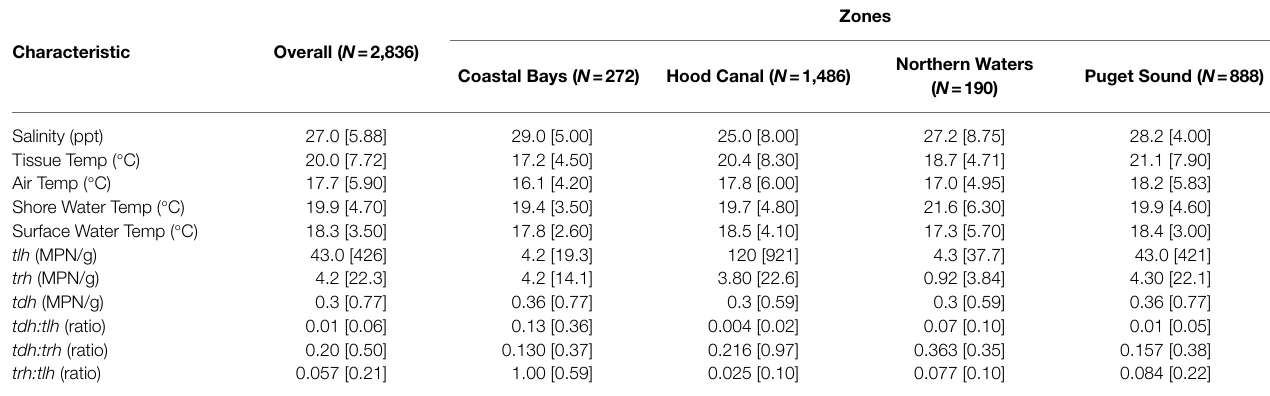
TABLE 1 | Descriptive characteristics of environmental and genetic variables including variation across sampling